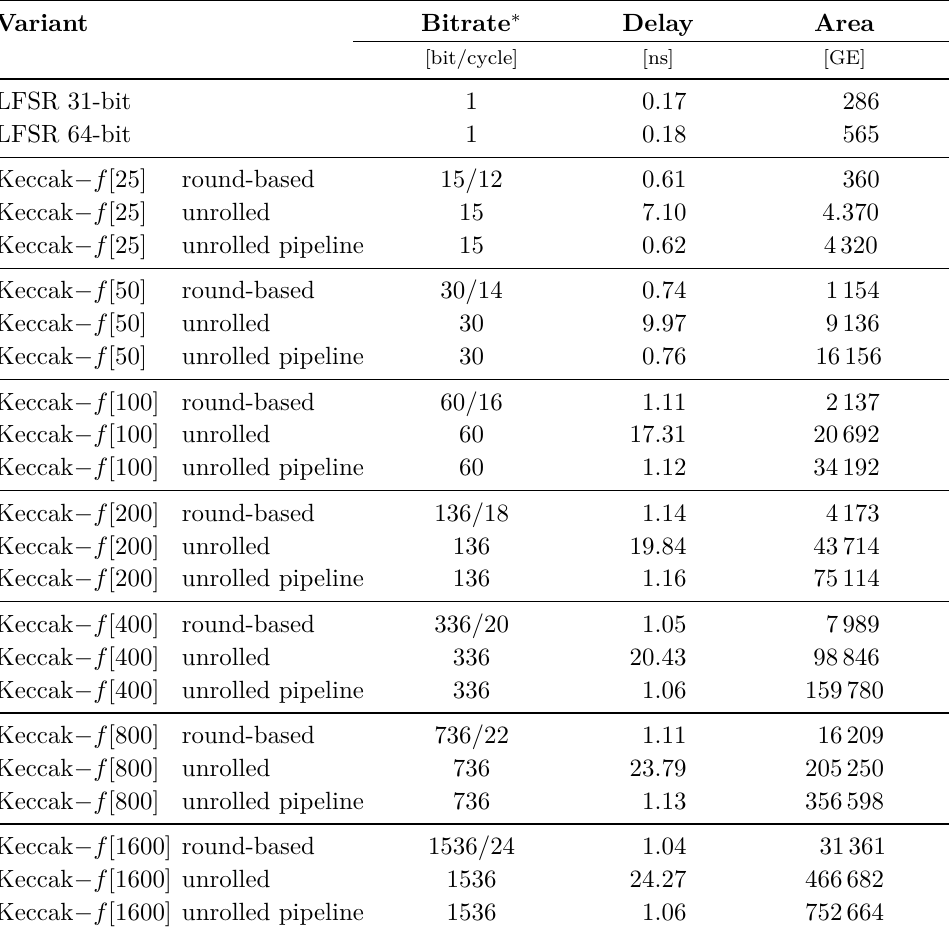
Table 2: Performance figures of different